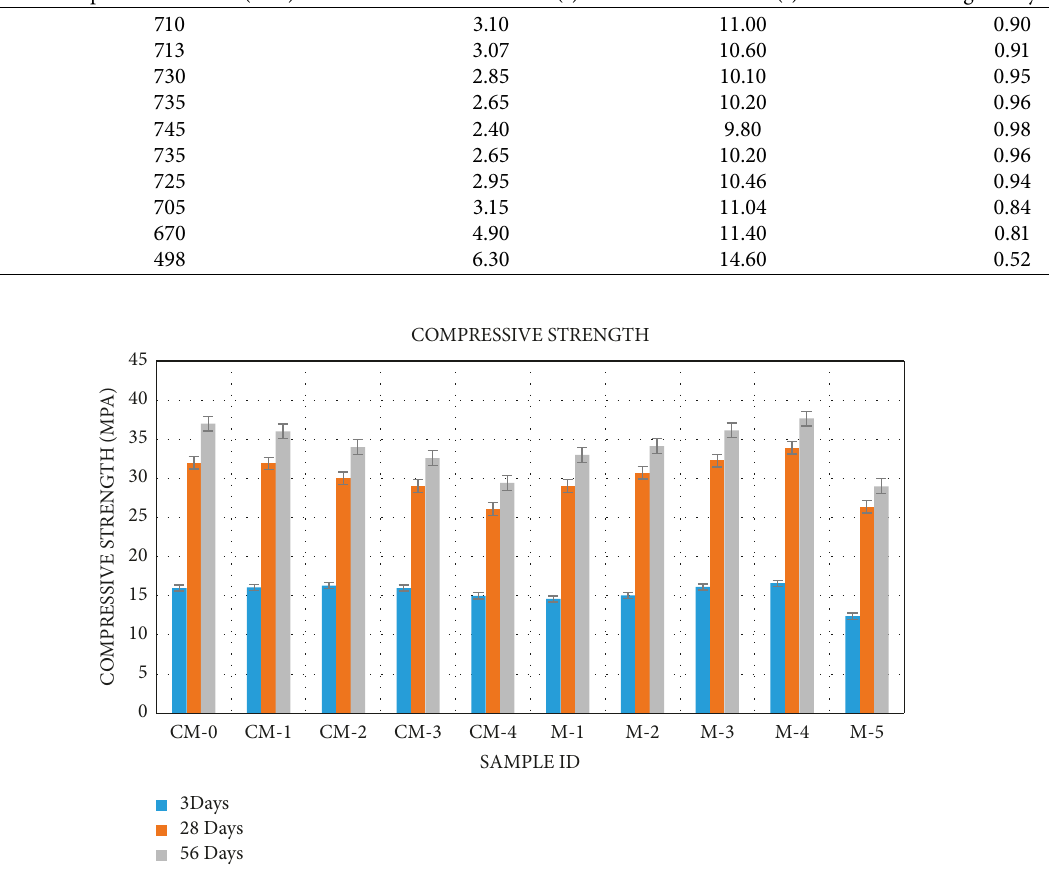
Figure 4: 3D surface diagram for split tensile